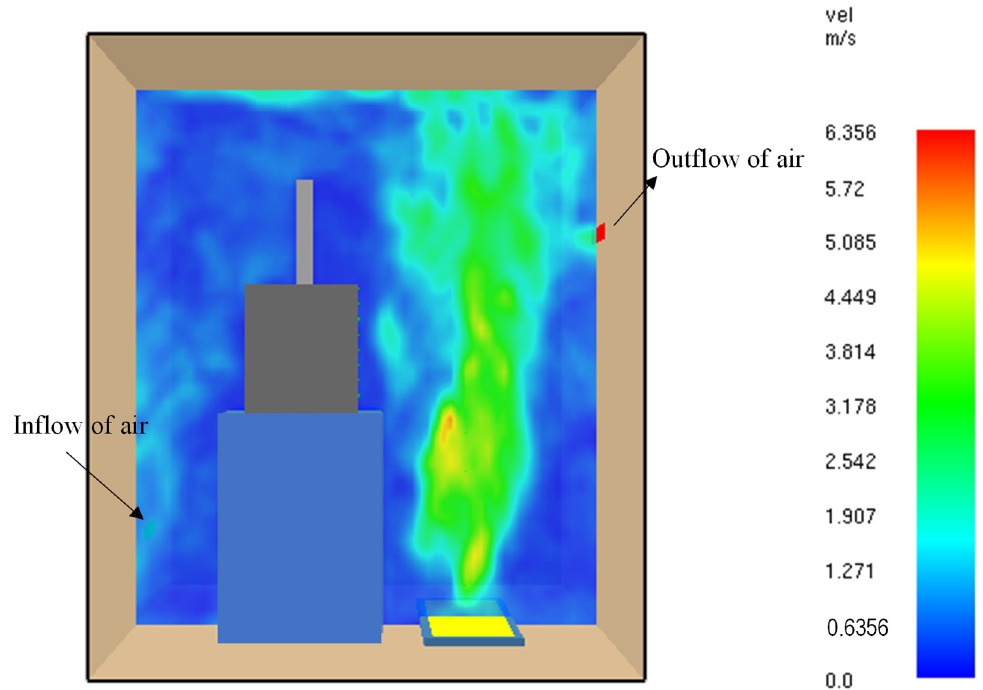
Figure 11. The temperature profile of the cleaning system and enclosure ( a ) from the fire facing side ( b ) front view fire facing side after 500 s.